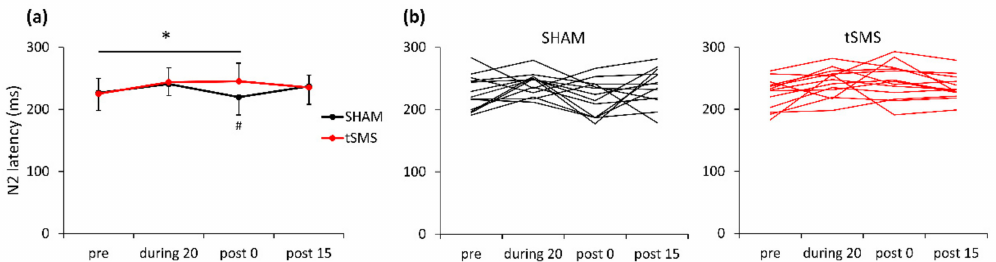
Figure 4. Mean ( a ) and individual ( b ) N2 latencies during the 2-back task. * p < 0.05 pre vs. post 0, # p < 0.05 tSMS vs. SHAM at post